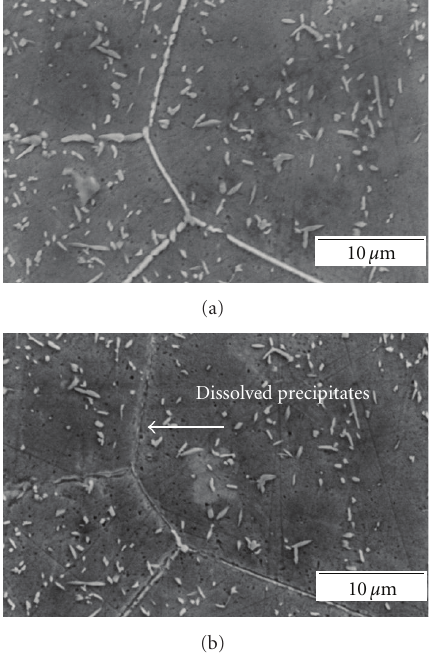
Figure 8: SEM micrographs of the electrolytically tested JJ1 steel after aging at 1123 K for 1000 min (a) at 25 mV and (b) at 75mV in Figure